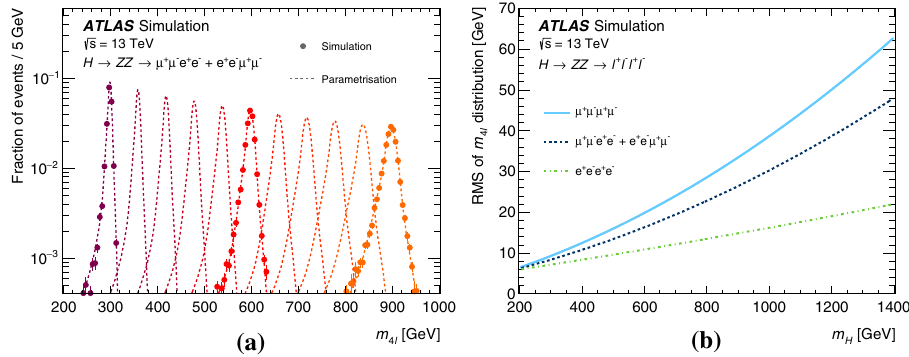
Fig. 1 a Parameterisationofthefour-leptoninvariantmass( m 4 (cid:3) )spec- trum for various resonance mass ( m H ) hypotheses in the NWA. Mark- ers show the simulated m 4 (cid:3) distribution for three specific values of m H (300, 600, 900 GeV), normalised to unit area, and the dashed lines show leading muon pair. An additional control region ( e μμμ ) is used to improve the t ¯ t background estimate. Transfer